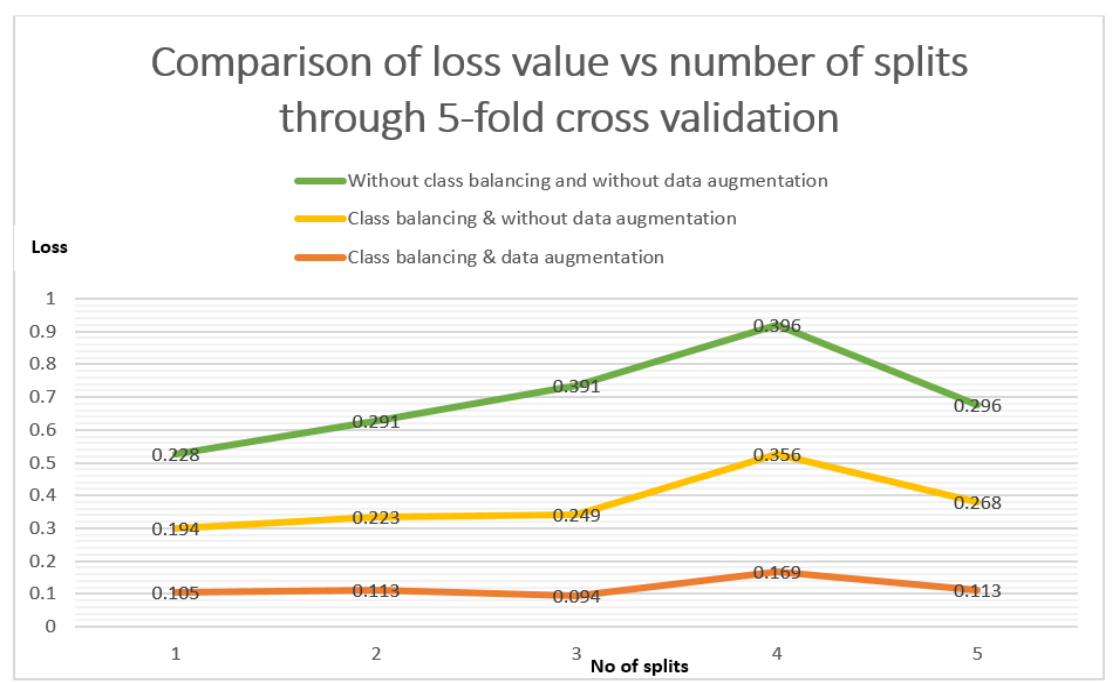
Figure 8. Loss comparison of class balancing and augmentation through 5-fold cross validation.